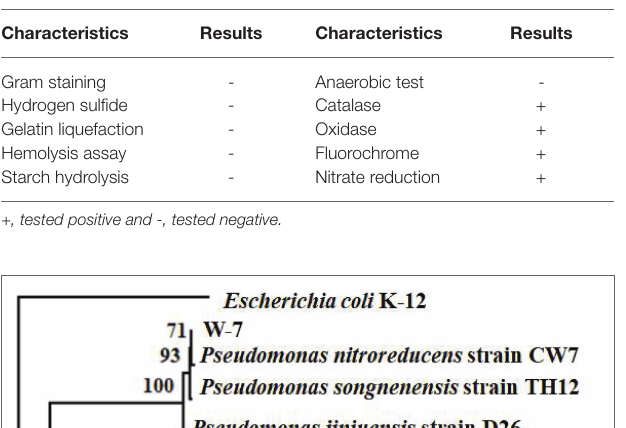
TABLE 1 | Biochemical characteristics of strain